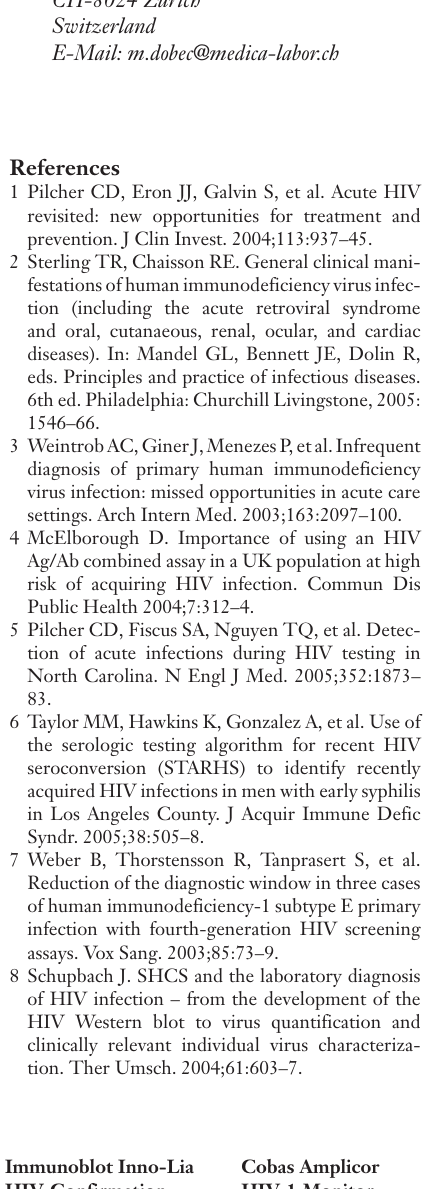
Comparison of HIV- EIA 4 th generation, immunoblot and PCR in a serum initially negative by 3 rd gener- ation HIV EIA screen-